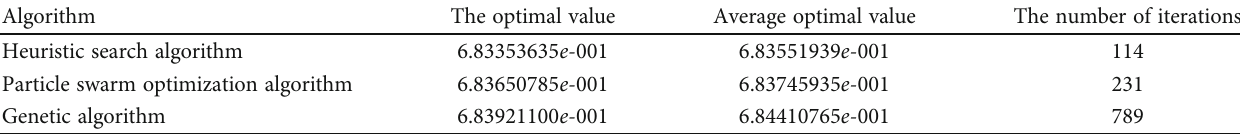
Table 1: Comparison of optimization results of the three